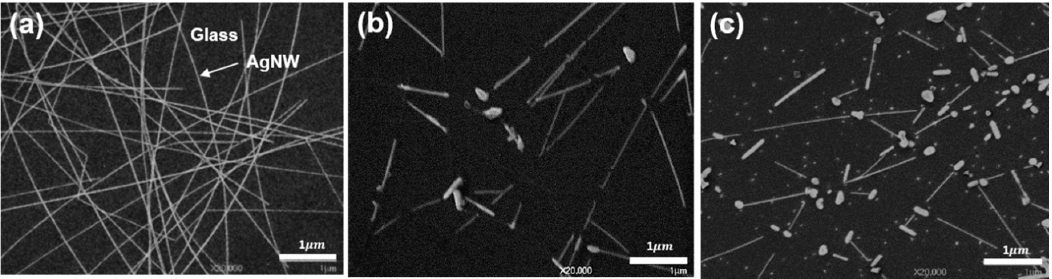
Figure 1. Field emission scanning electron microscopy (FE-SEM) top-view images of ( a ) silver nanowire film (AgNW), ( b ) heated at 230 °C (AgNW-230 °C), and ( c ) 280 °C (AgNW-280 °C).